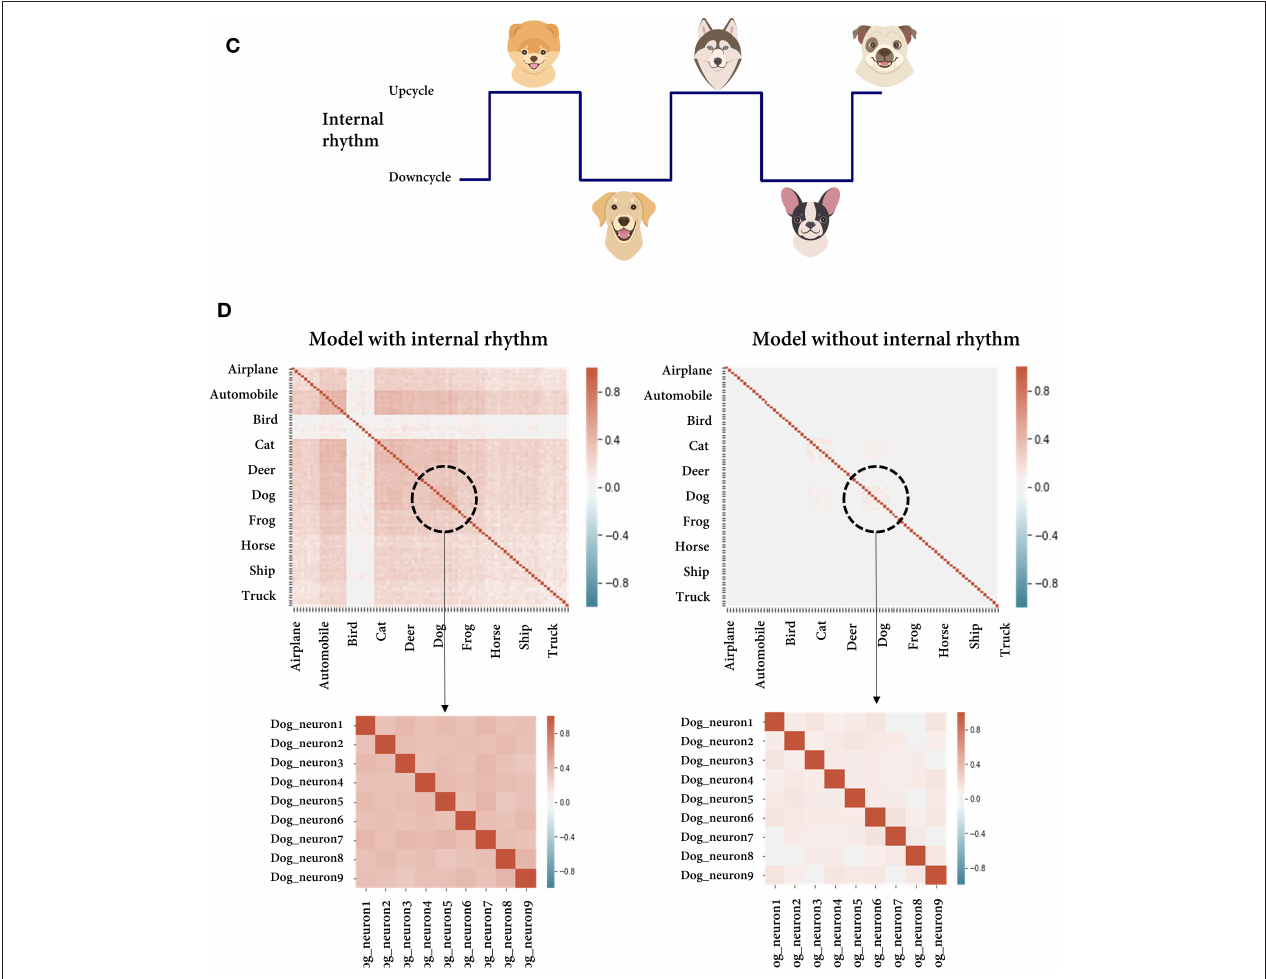
FIGURE 5 | Overestimation of the noise correlation. (A) Schematic figure to illustrate the simulated situation in which the feature of a stimulus defined by the researcher is the dog class (right, coarse-grained representation) and the recording region actually encodes the feature at the level of individual dog breeds (left, fine-grained representation). From the perspective of neurons encoding the breeds, dog images of different breeds were recognized as different stimuli, while the researcher regards them as an identical stimulus. (B) Correlation matrices of individual neural activities randomly sampled from the model assumed to encode either the dog breed or the dog class (fine-grained/coarse-grained representation model). The enlarged parts are the values from the individual neurons within the dog unit. (C) Schematic figure illustrating the simulated situation in which a periodic internal state is globally encoded by the neural population and stimuli are presented alternately in the upcycle and downcycle of the rhythm. (D) Correlation matrices of individual neural activities randomly sampled from the model with/without a periodic internal